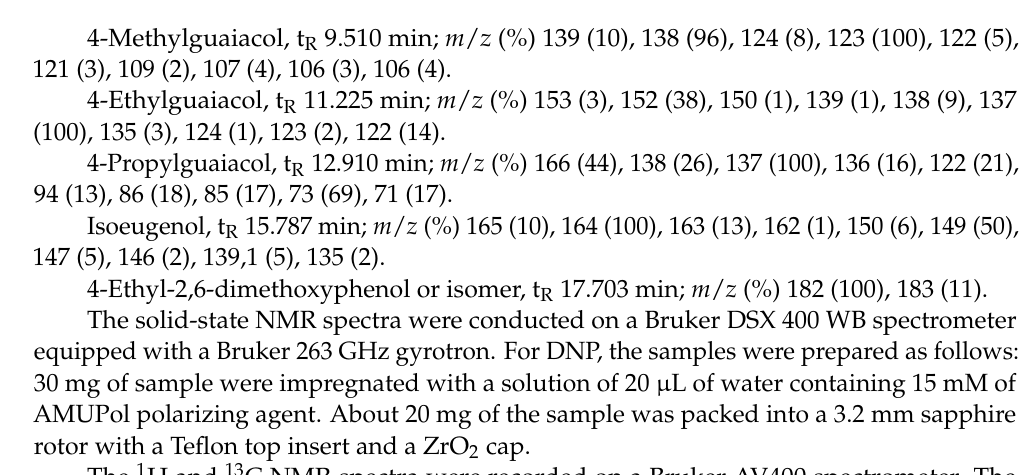
Ru/C, Figure S2: Powder XRD measurement of Pt/C. The red lines indicate the reflexes of cubic Pt as recorded in the Crystallography Open Database (record no. CDO 1011107), Figure S3: Overlay plot of the HSQC NMR spectra of the parent kraft lignin (blue and green) and the lignin oil (red and pink) obtained by the Pt/C catalyzed hydrogenolysis of kraft lignin in methanol at supercritical conditions (30 bar initial hydrogen pressure, 131 bar pressure at 250 ◦ C), Figure S4: 1 H and 13 C{ 1 H} NMR spectrum of lignin oil obtained by catalytic hydrogenolysis over Ru/C, Figure S5: 1 H and